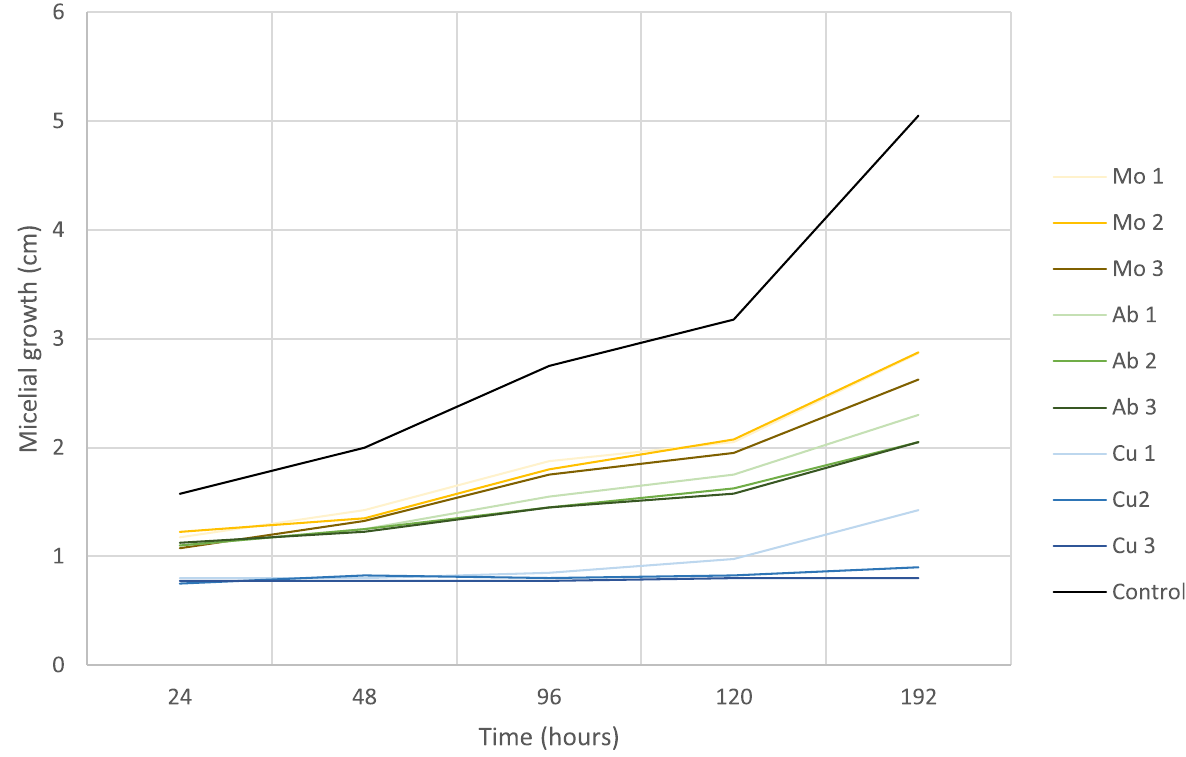
Fig. 4 Growth of Beauveria bassiana 2067 in media containing different concentrations of pesticides (Mo: mineral oil, Ab: abamectin, Cu: copper oxychloride). Mo1: 12.25 ml/l, Mo2: 17.5 ml/l, Mo3: 22.75 ml/l; Ab1: 350 μ l/l, Ab2: 500 μ l/l, Ab3: 650 μ l/l; Cu1: 1.75 g/l, Cu2: 2.50 g/l, Cu3: 3.25